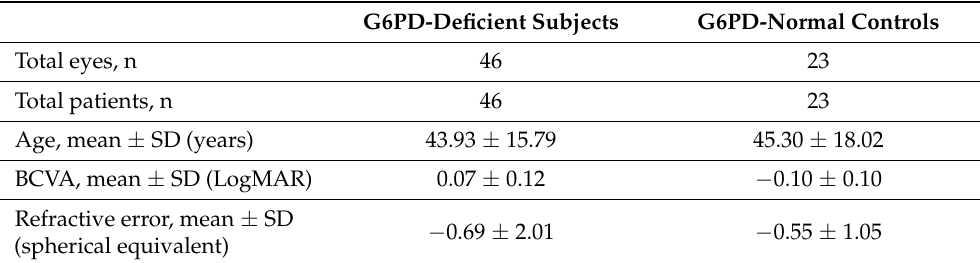
Table 1. Demographic and clinical data of glucose-6-phosphate-dehydrogenase (G6PD)-deficient patients and G6PD-normal controls.